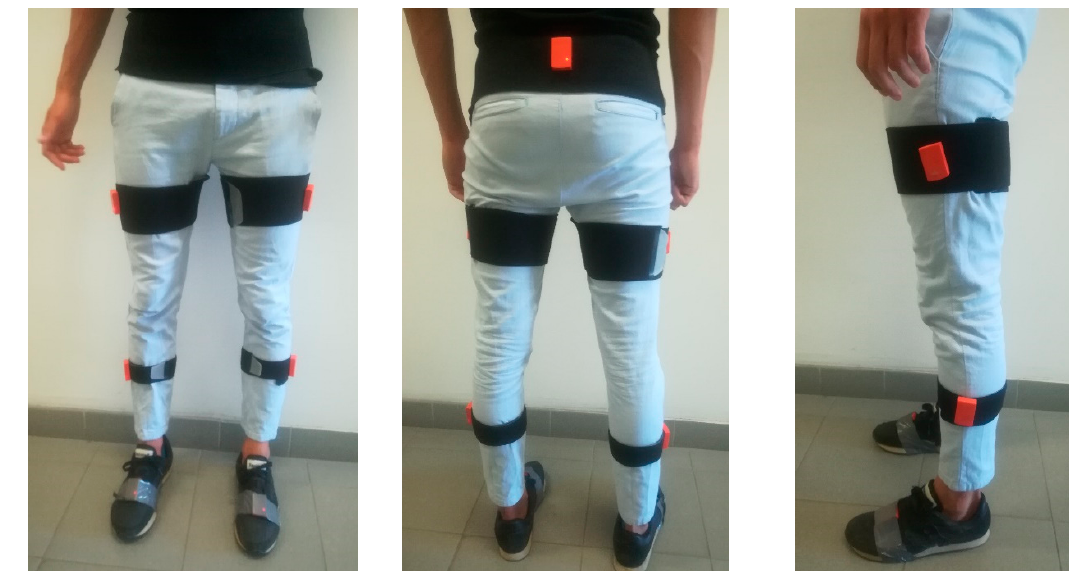
Figure 1. Example of IMU (inertial measurement unit) placement on lower limbs of one subject: frontal, back, and lateral view.